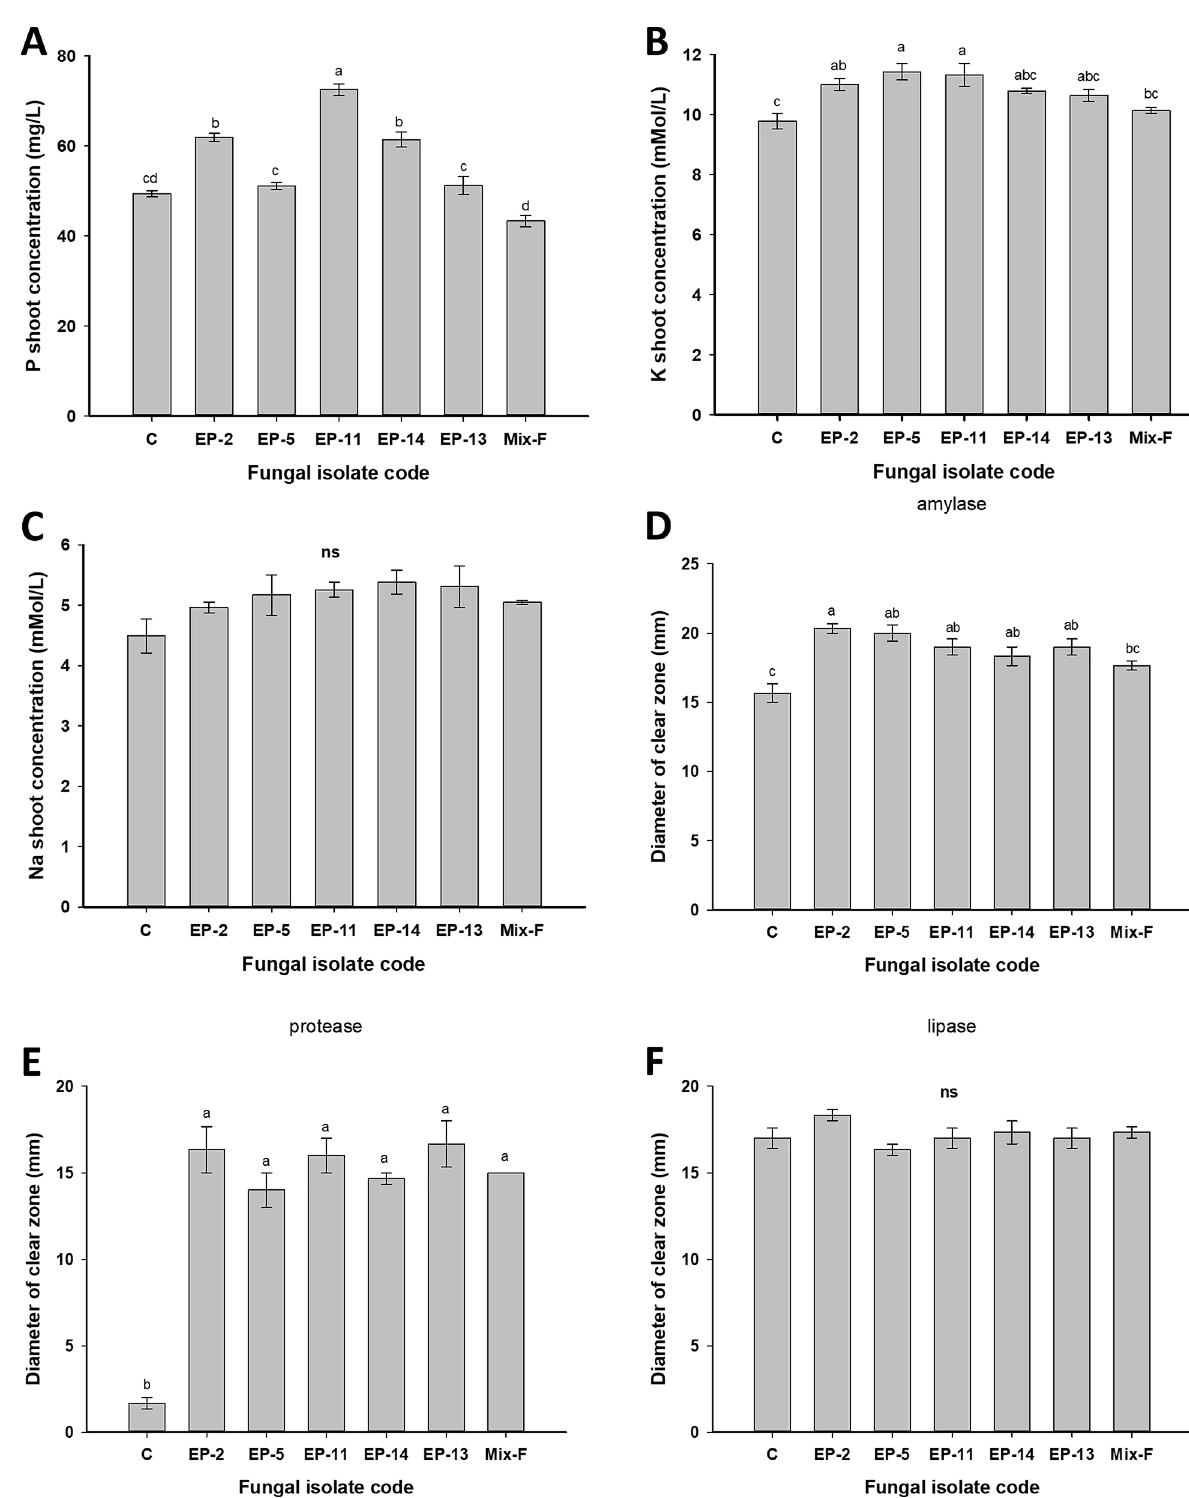
Figure 4. Effect of fungal inoculation on Zea mays L. plant growth performance. ( A ) P shoot concentration; ( B ) K shoot concentration; ( C ) Na shoot concentration; ( D ) amylase plant extracellular enzyme activity; ( E ) protease plant extracellular enzyme activity and ( F ) lipase plant extracellular enzyme activity. Mix_F is the consortium between five fungal endophytic strains. Error bars are ± SE ( n = 3). Different letters on bars denote that mean values are significantly different ( p ≤ 0.05) by the Tukey LSD test. ns denotes not